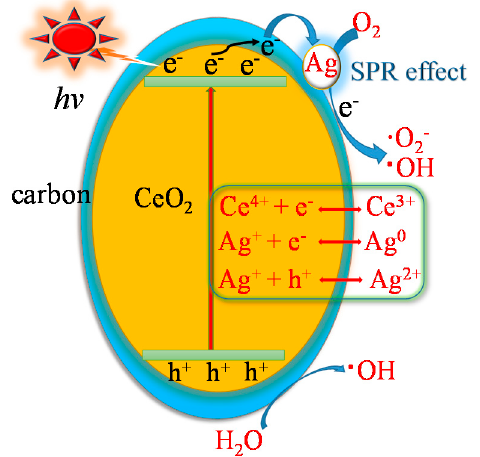
Figure 9. Electron spin resonance (ESR) spectra of 3-Ag / CeO 2 @C-2 for DMPO– · O 2 − in methanol ( A ) and DMPO– · OH in aqueous ( B ).